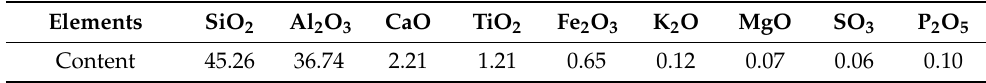
Table 1. Chemical composition of raw materials (wt.%).